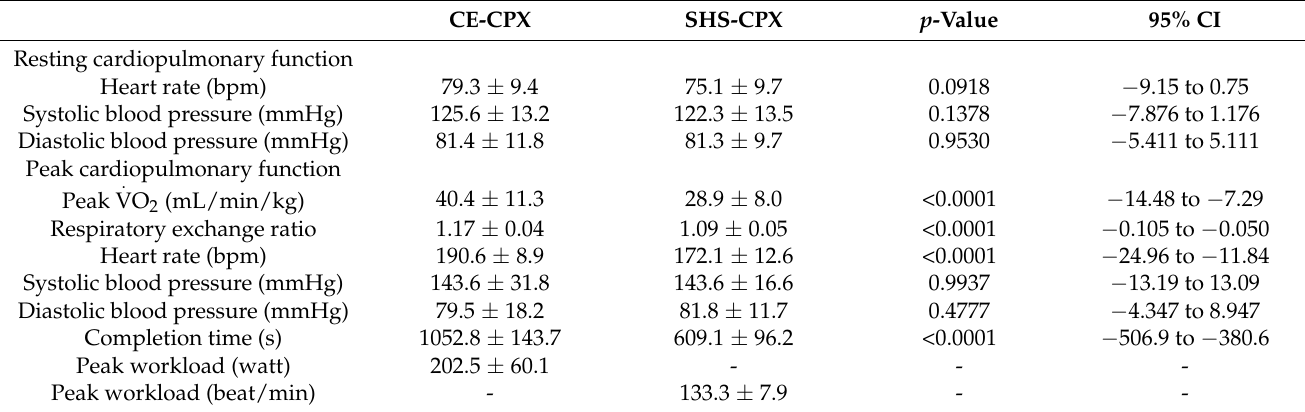
Table 2. Measurements obtained at peak exercise and at